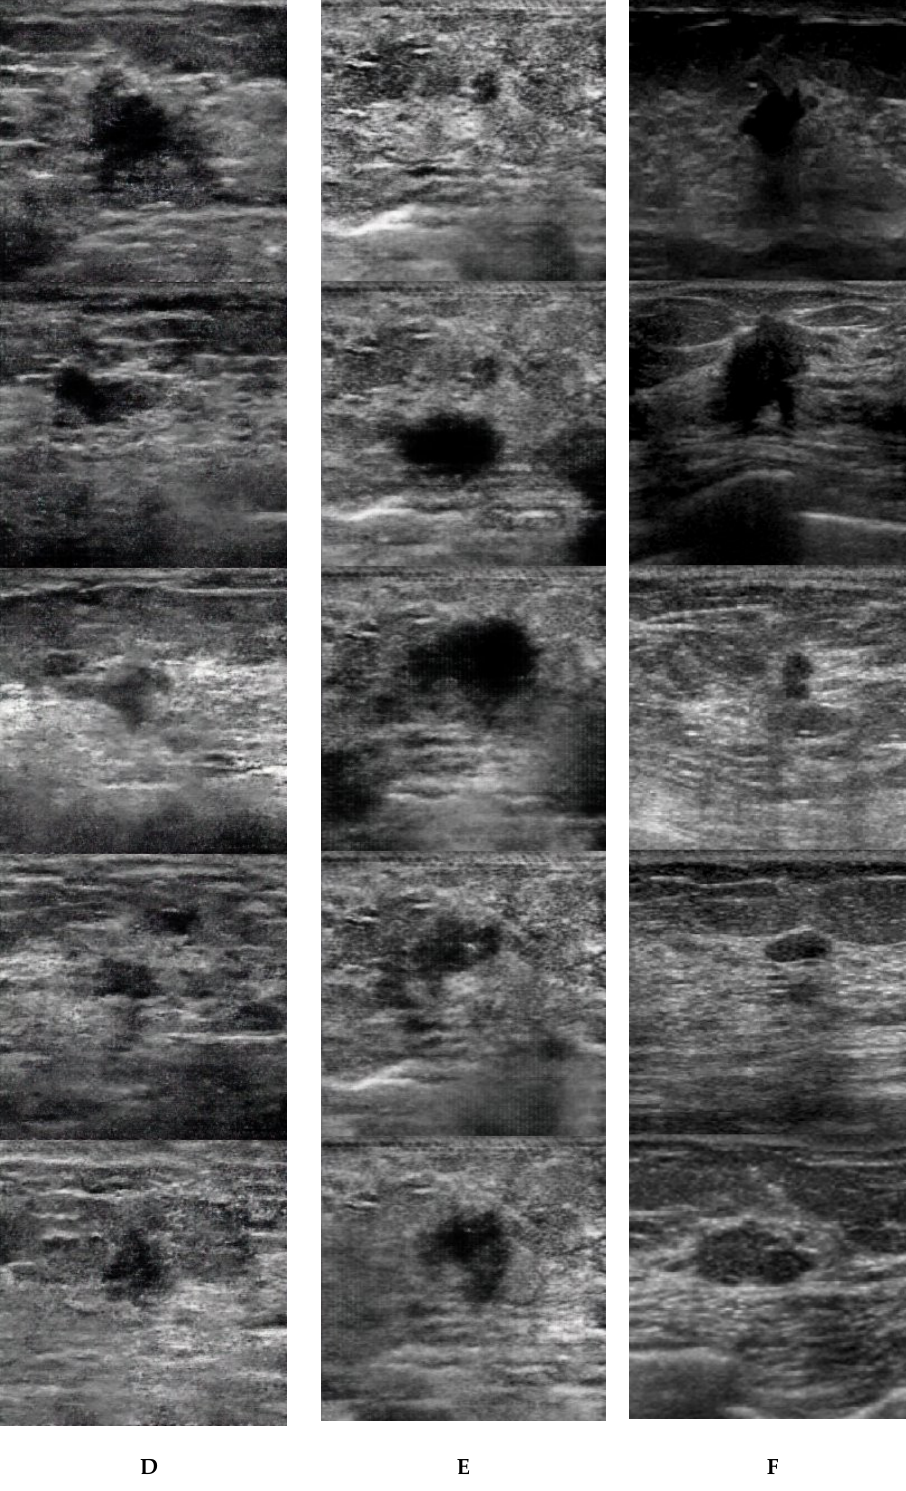
Figure 1. Examples of five synthetic images generated with 50 ( A ), 100 ( B ), 200 ( C ), 500 ( D ), and 1000 ( E ) epochs and the original images ( F